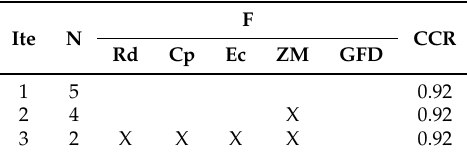
Table 8. Intra-modal selection. Correct classification rates obtained when applying selection process on DECEDM shape features. Ite: iteration. N: number of features kept. F: features. CCR: correct recognition